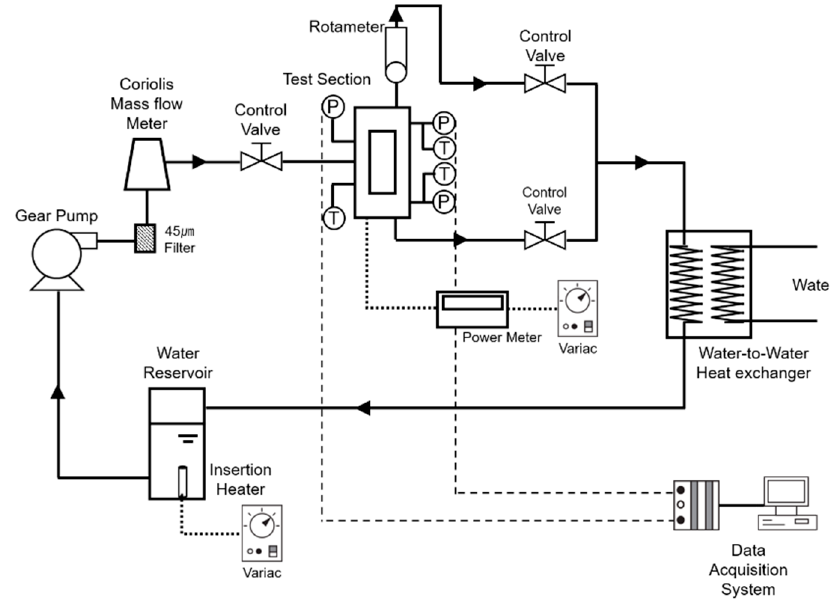
Figure 1. Schematic of flow loop.